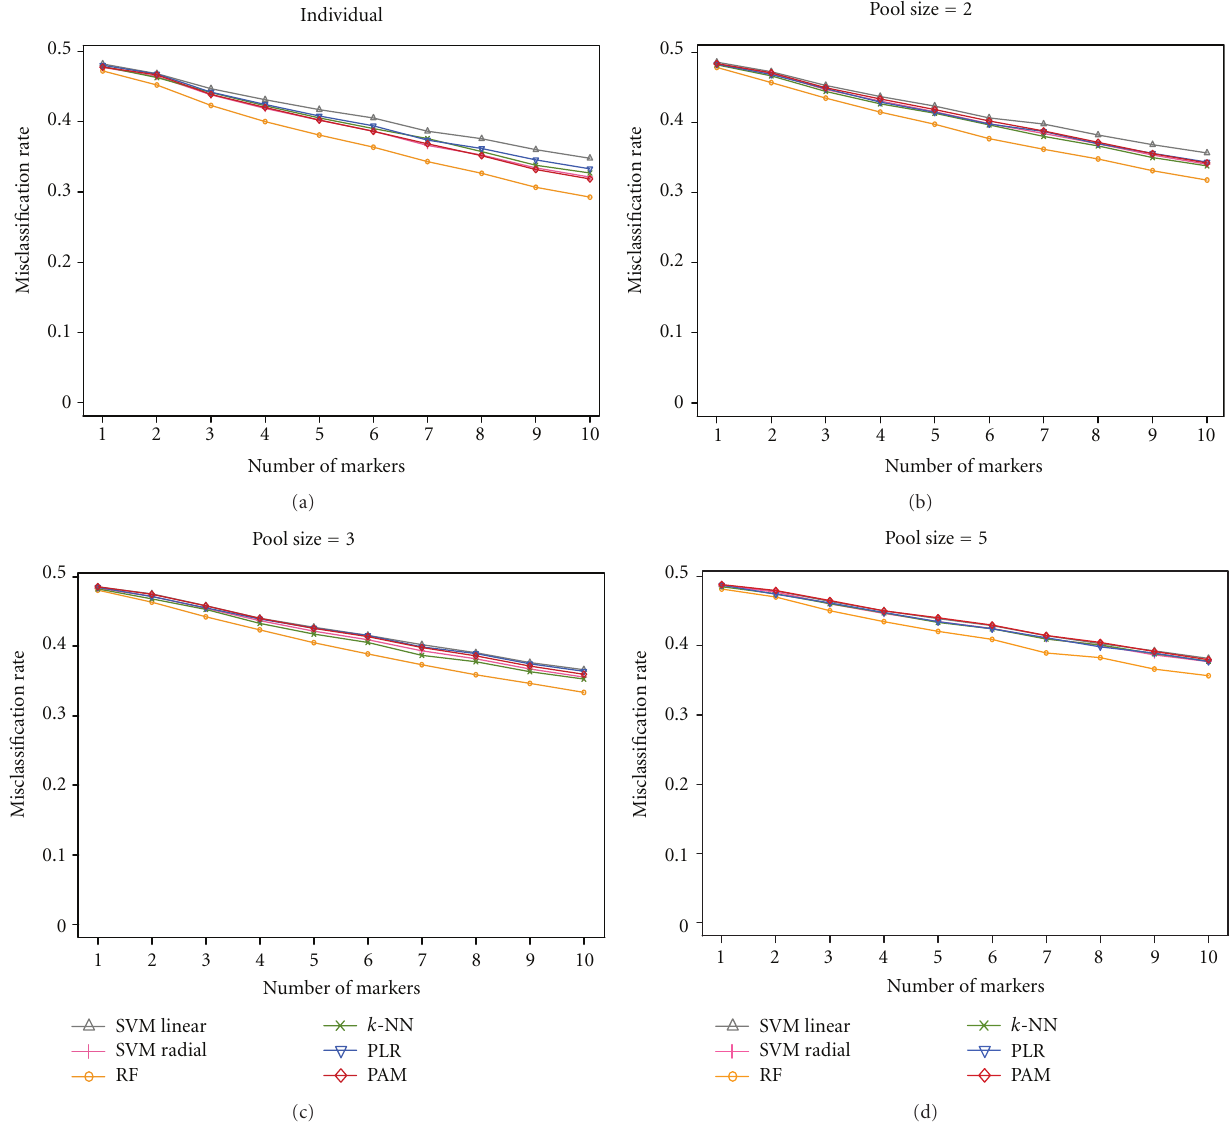
Figure 3: The performance of classifiers for various numbers of markers based on non-pooled and pooled data. Misclassification rates of classifiers are shown when the number of markers is increasing from 1 to 10. (a) shows the performance of classifiers on dataset of individual samples (90 controls and 90 cases). (b)–(d) show the performance of classifiers on pooled datasets when pool sizes are 2, 3, and 5,